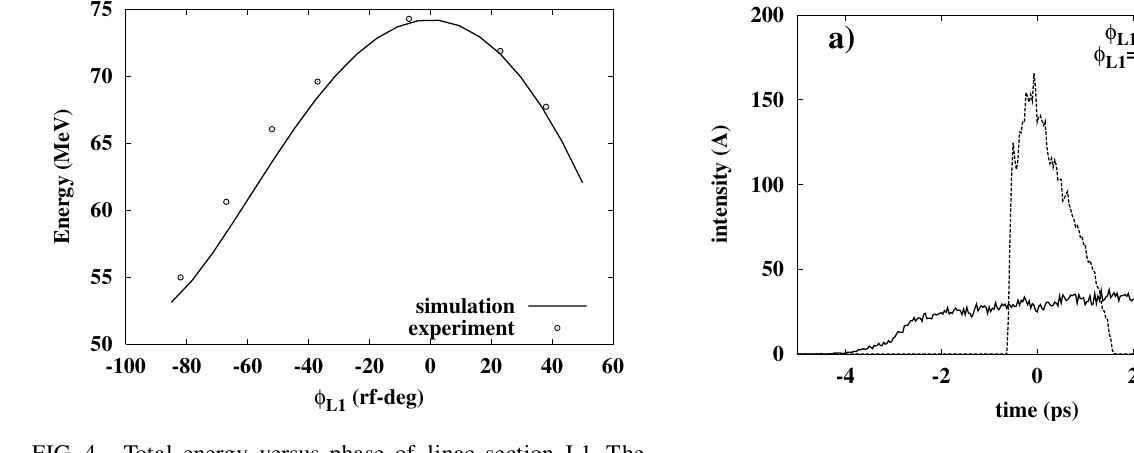
FIG. 4. Total energy versus phase of linac section L1. The points are measurements obtained parasitically to the bunch length measurement. The solid line is a simulation